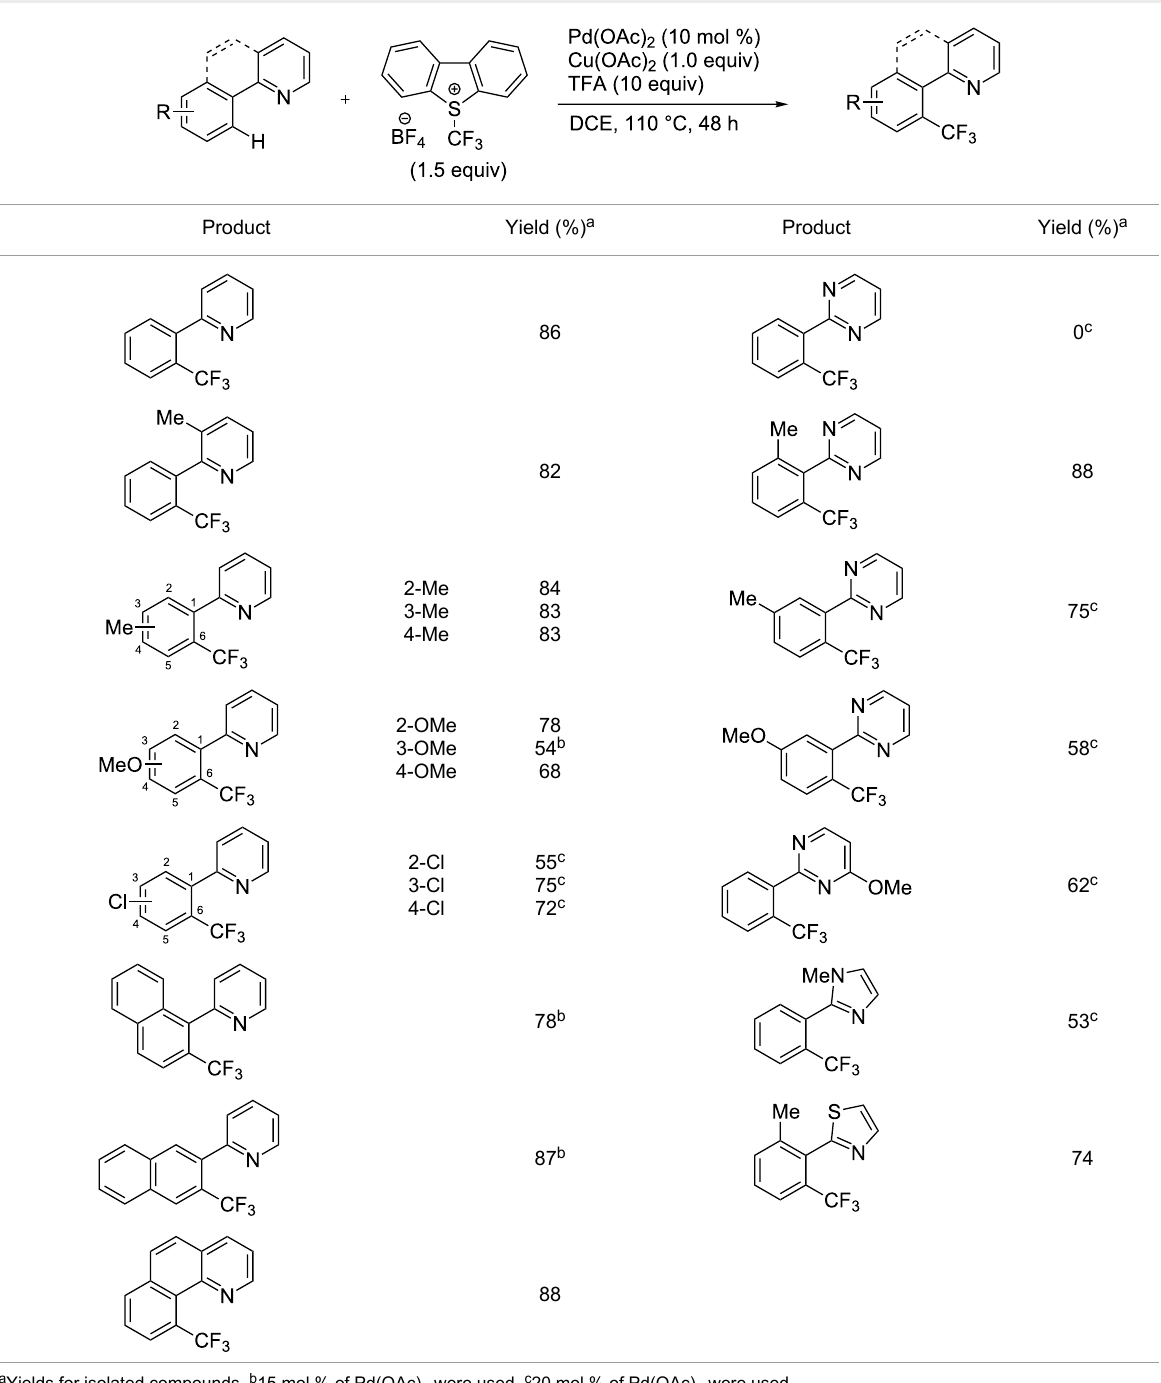
Table 5: Pd-catalyzed C–H trifluoromethylation employing Umemoto’s sulfonium tetrafluoroborate salt